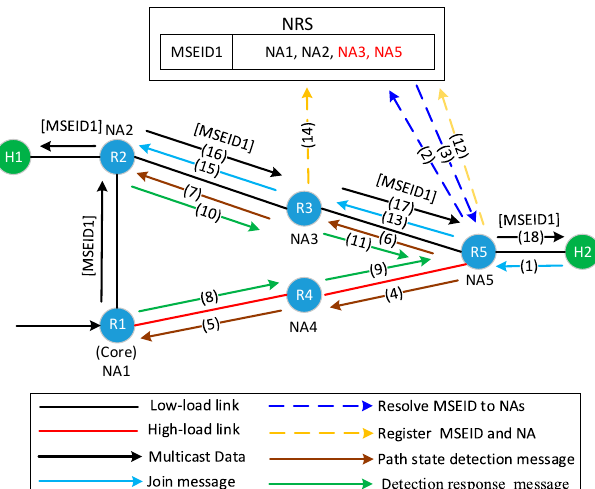
Figure 4. The example of the multicast tree node selection process.